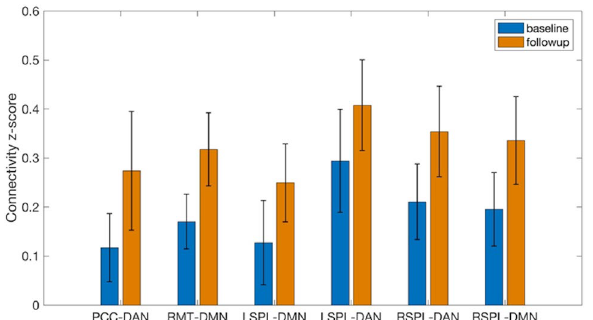
Figure 5. The increases of functional connectivity z-scores from baseline to follow-up. The bars stand for standard deviations. PCC posterior cingulate cortex, RMT right medial temporal region, LSPL left superior parietal lobe, RSPL right superior parietal lobe, DAN dorsal attention network, DMN default mode network.